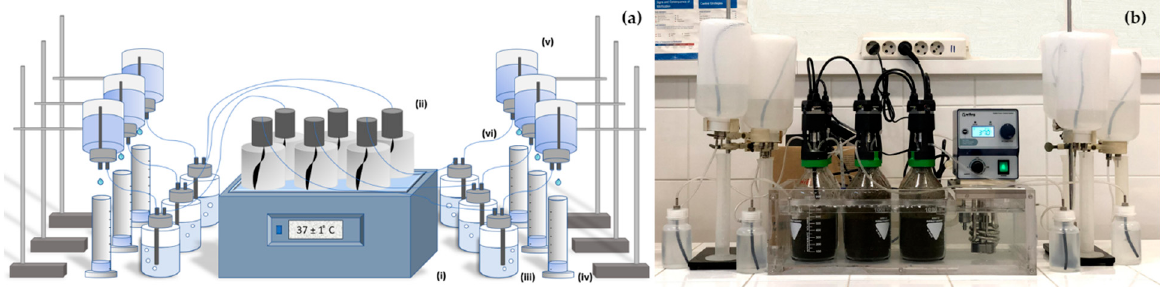
Figure 2. ( a ) Experimental test set up: ( i ) water bath; ( ii ) anaerobic reactors; ( iii ) carbon dioxide separating unit; ( iv ) graduated cylinder; ( v ) inverted bottle; ( vi ) capillary tube. ( b ) Experimental set up photo.